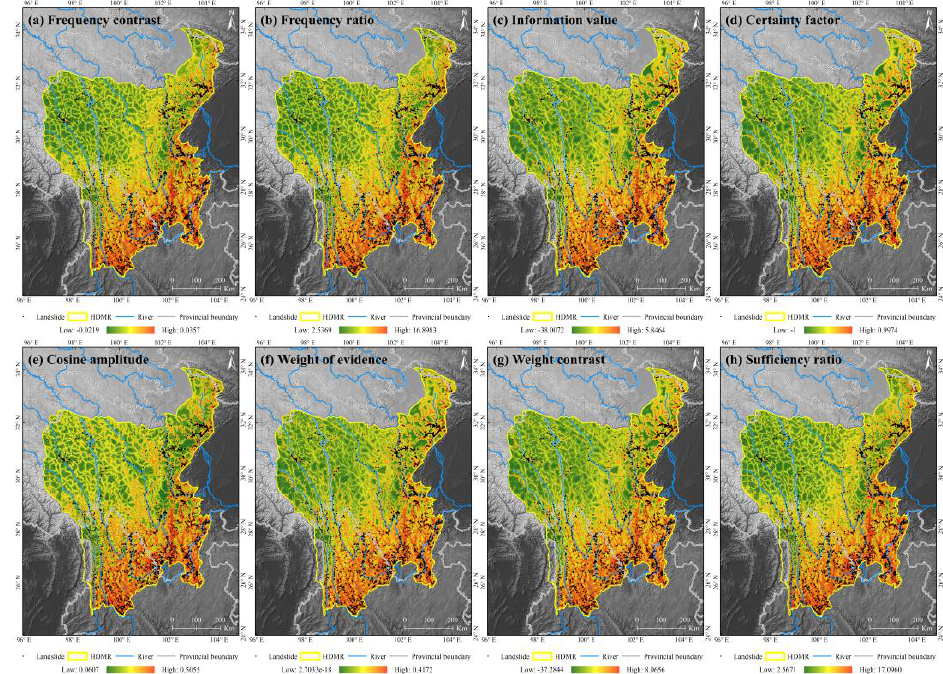
Figure 7. Landslide susceptibility maps produced using optimal bivariate methods in the case study. ( a ) The frequency contrast method. ( b ) The frequency ratio method. ( c ) The information value method. ( d ) The certainty factor method. ( e ) The cosine amplitude method. ( f ) The weight of evidence method. ( g ) The weight contrast method. ( h ) The sufficiency ratio method. Histogram equalization stretching is used in illustrations of landslide susceptibility index ( LSI ) values.